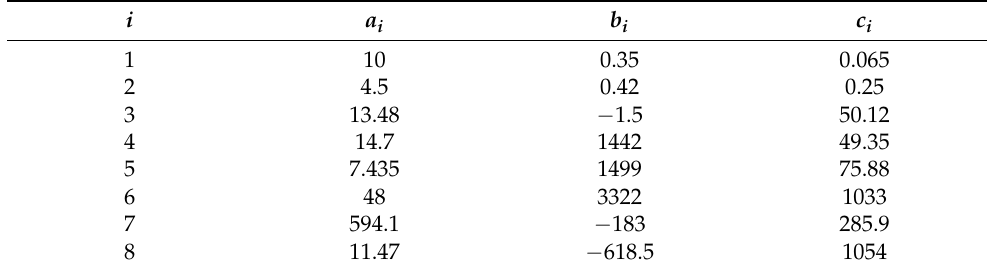
Table 1. Parameter a i , b i and c i values